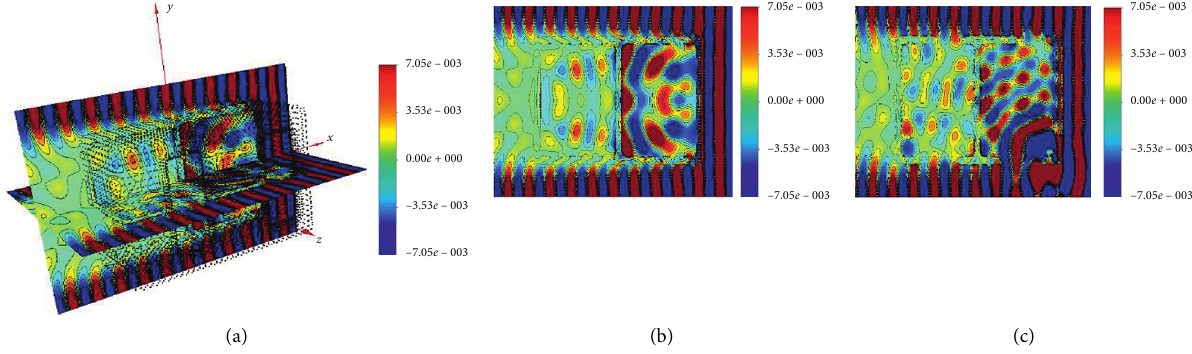
Figure 5: The isometric (a), x - y plane (b), and x - z plane (c) view of the rooms for